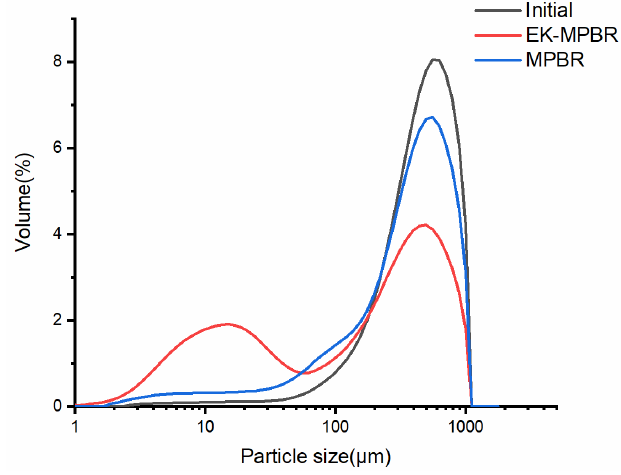
Figure 8. Particle size distribution of the floc suspension in the MPBR and EK-MPBR.